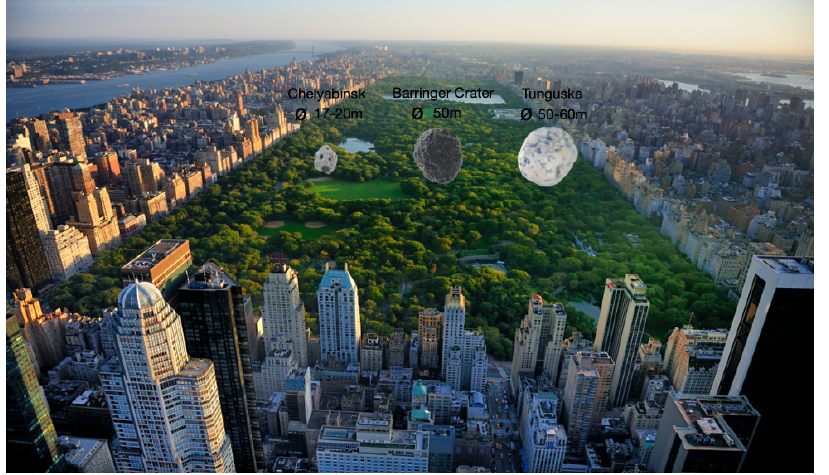
Figure 10. Comparisons of approximate sizes of three notable impactors with New York Manhattan as the